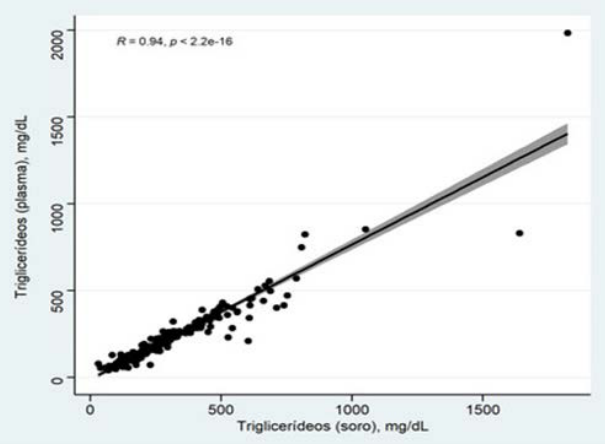
fIGuRE 1 – Correlation analysis for triglyceride quantifications between the serum and plasma samples (n=205).